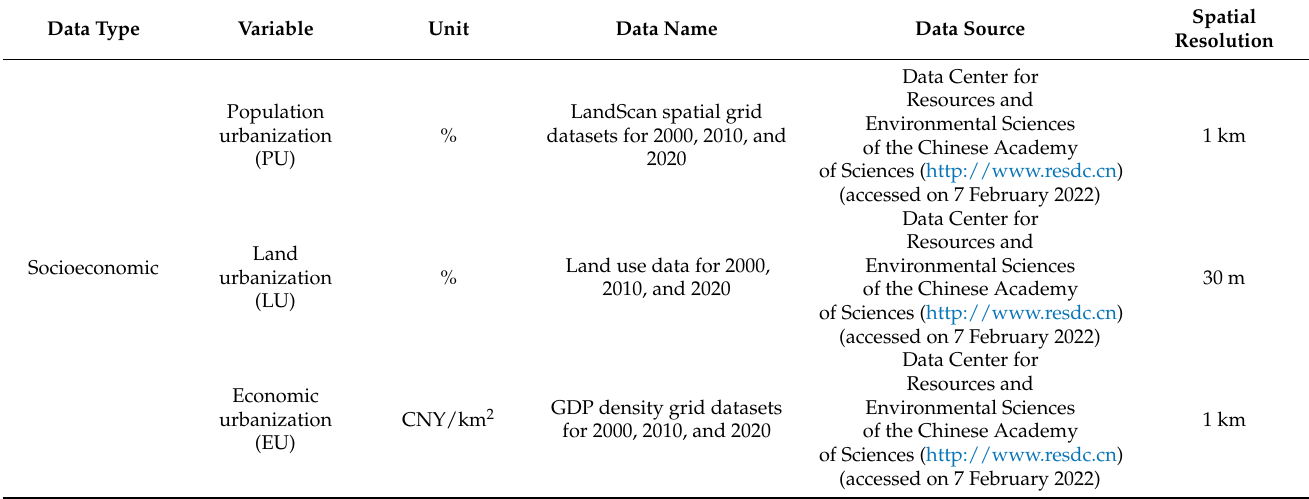
Table 1. Data sources for the various